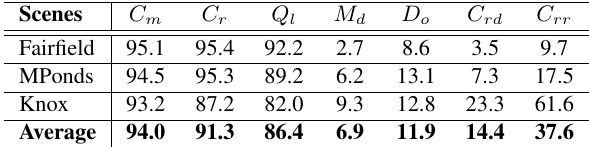
Table 1: Object-based evaluation results in percentages ( C m = completeness, C r = correctness, Q l = quality, M d = multiple de- tection rate, D o = Detection overlap rate, C rd = detection cross- lap rate and C rr = reference cross-lap rate).